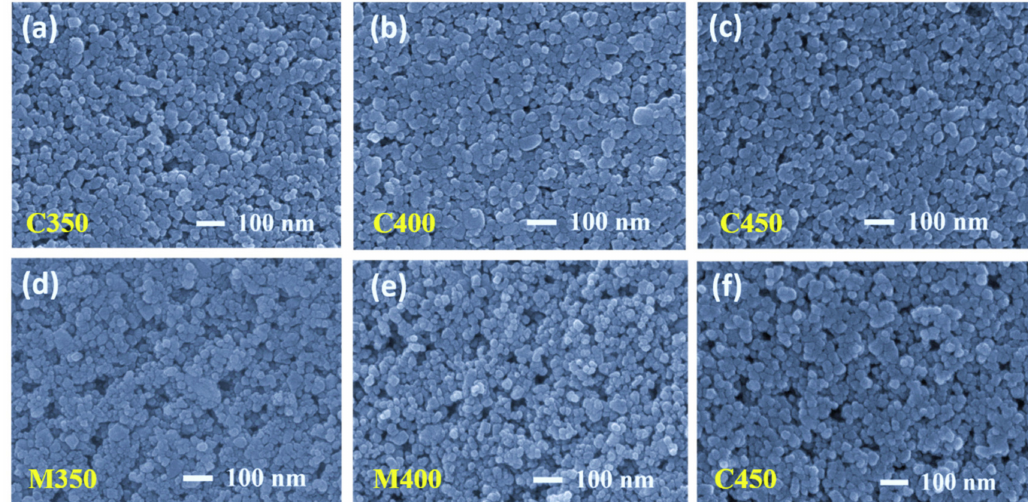
Figure 5. Scanning electron microscopy surface (top) view images of ( a – c ) Conventionally sintered titania films and ( d – f ) Microwave sintered titania